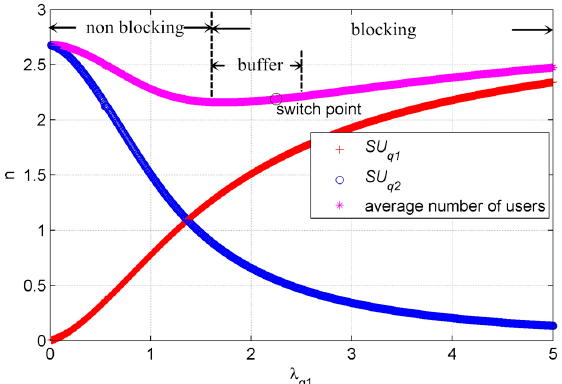
Figure 7. Average number of users as λ q 1 and λ q 2 vary.